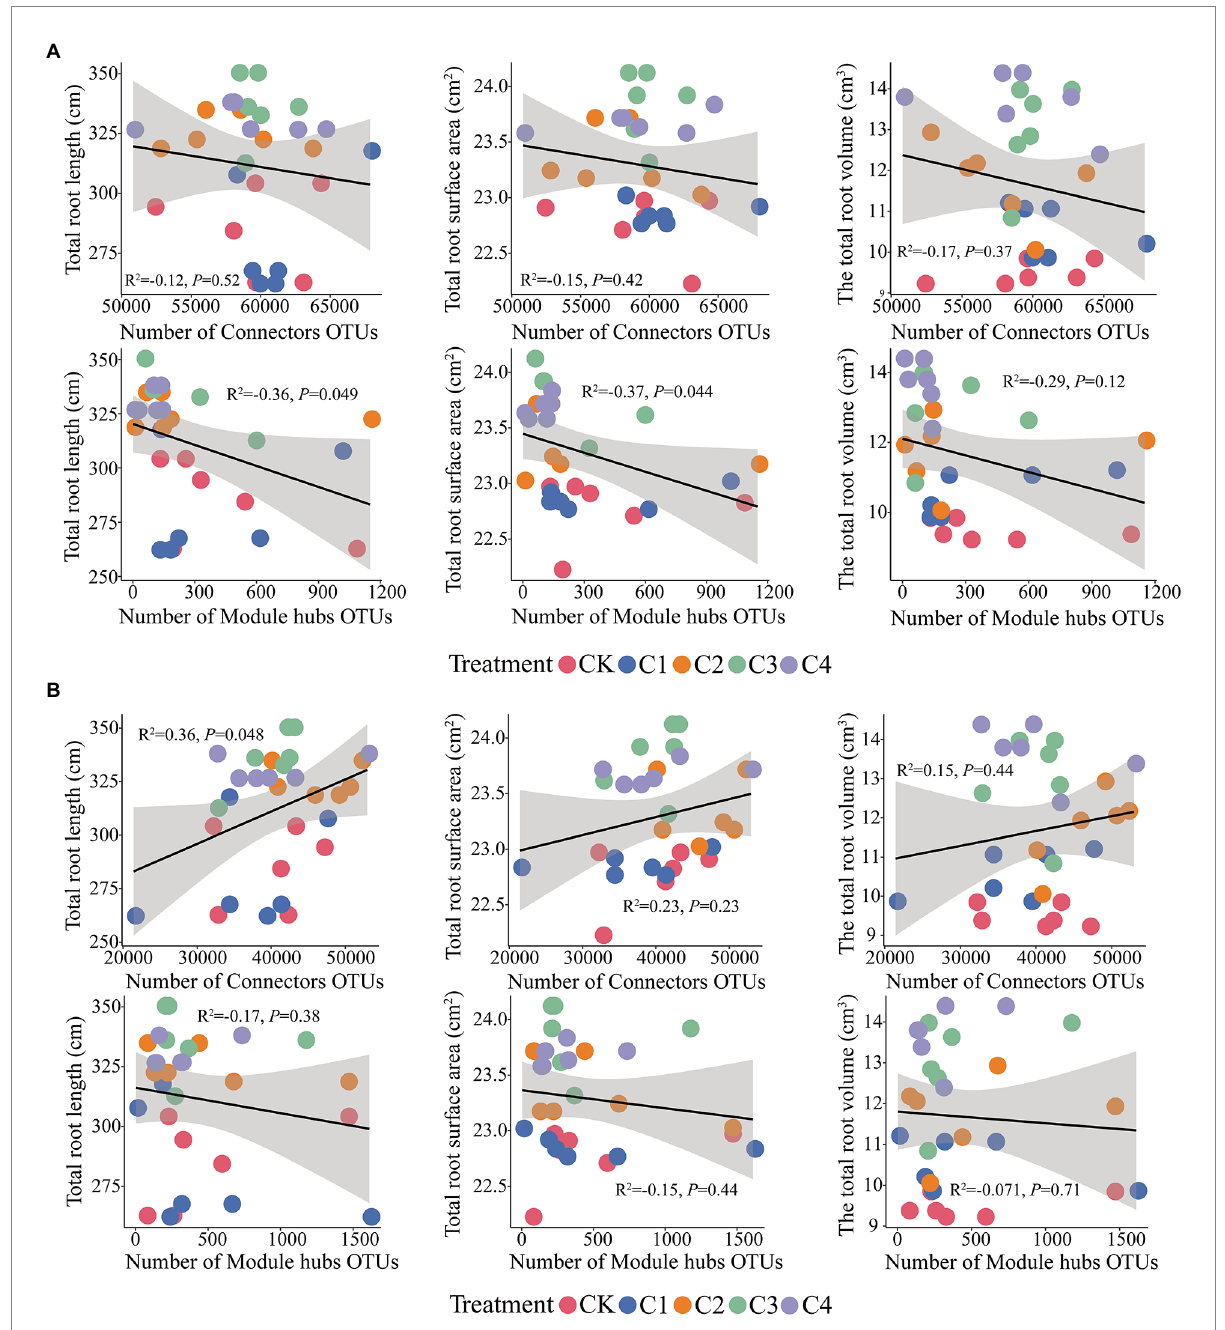
FIGURE 8 Effect of core microbial taxa on the architecture of maize roots. (A) Effect of microbial taxa in bulk soil on the architecture of maize roots. (B) Effect of microbial taxa in rhizosphere soil on the architecture of maize